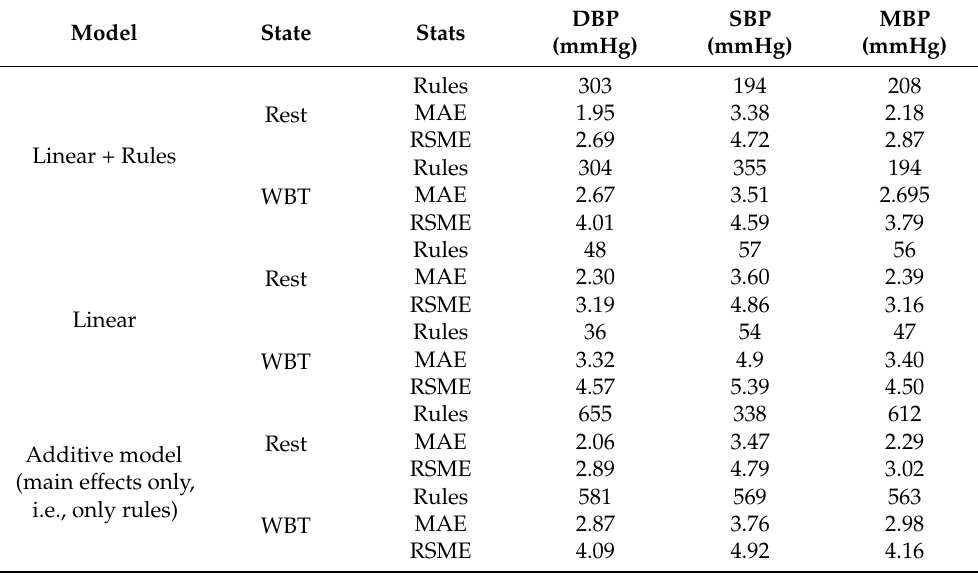
Table 2. Evaluation criteria for the comparison models. MAE, mean absolute error; RMSE, root mean square error; WBT, weight-bearing test; DBP, diastolic blood pressure; SBP, systolic blood pressure; MBP, mean blood pressure. Rules refers to the number of rules obtained from the model. Model State Stats